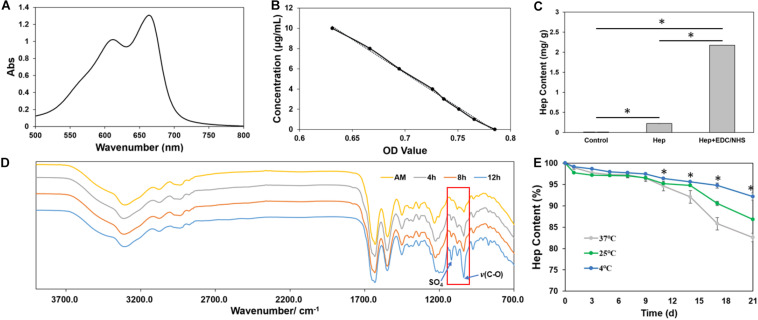
Characterization of grafted heparin onto AM. (A) UV absorption curve of heparin combined with methylene blue from 500 to 800 nm. (B) Concentration–absorbance standard curve of heparin combined with methylene blue. (C) The amount of grafted heparin on amniotic membrane. (D) Infrared spectra of amniotic membrane grafted with heparin. (E) Time-dependent changes of heparin content in AM at different temperatures. ∗Statistically significant at p ≤ 0.05.